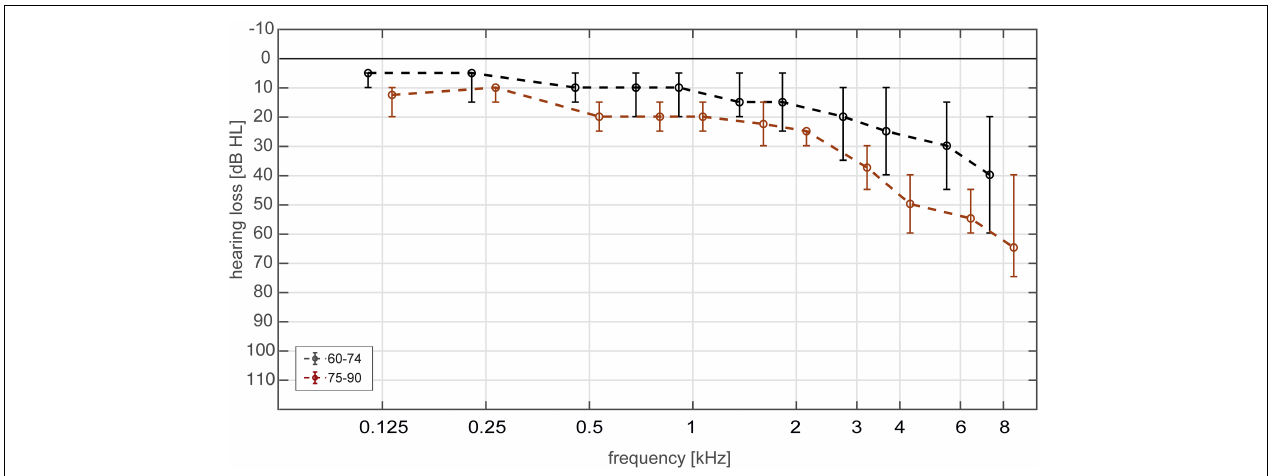
FIGURE 3 | Hearing thresholds (median and interquartile range) of 80 ears (40 subjects) divided into two age groups. Age groups were 60–74 (black) and 75–90 (red) years.